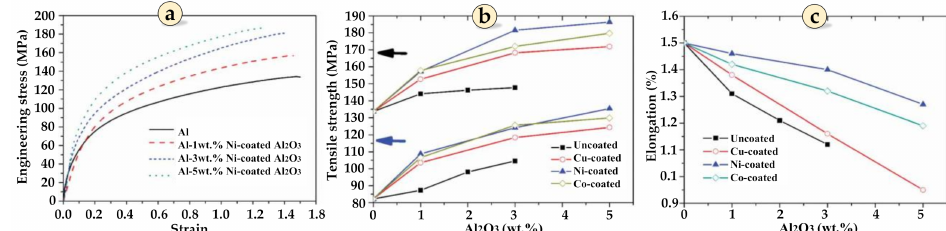
Figure 12. Mechanical properties of aluminum matrix composites strengthen by Al 2 O 3 with 3.0 wt.% Ni, Co or Cu coating shells. ( a ) stress-strain curve; ( b ) tensile stress and ( c ) elongation values versus alumina content reproduced from [168] with permission of Taylor & Francis